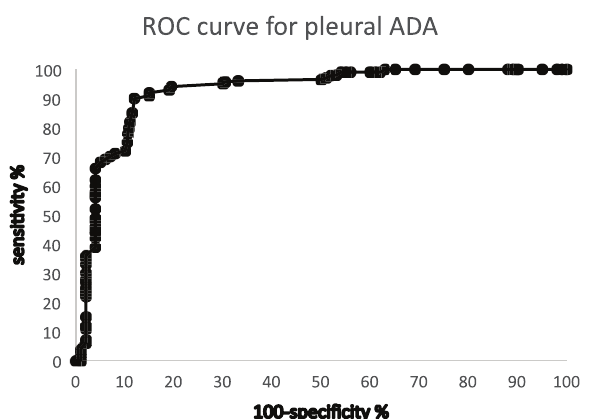
Data comparison graph of maximum and minimum values and medianvalues forpleuraladenosinedeaminase(ADA)intuberculous and nontuberculous pleural effusion, median, maximum and mini- mum were identified ( P